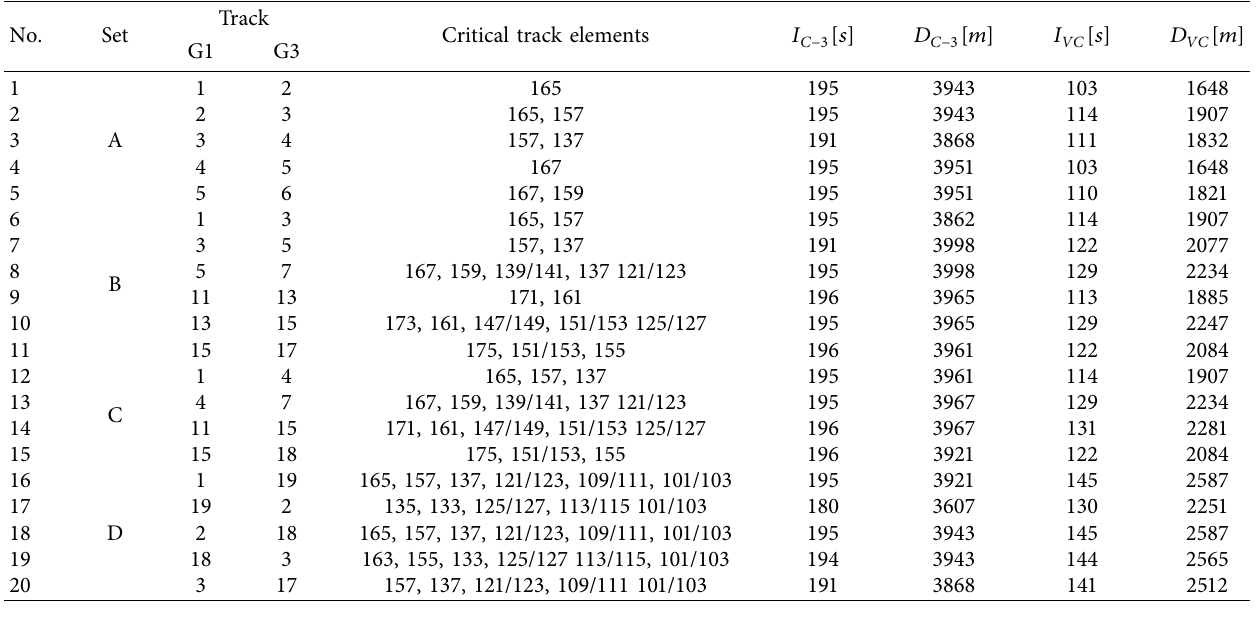
Table 8: Outcomes of train headways for scenario 6.